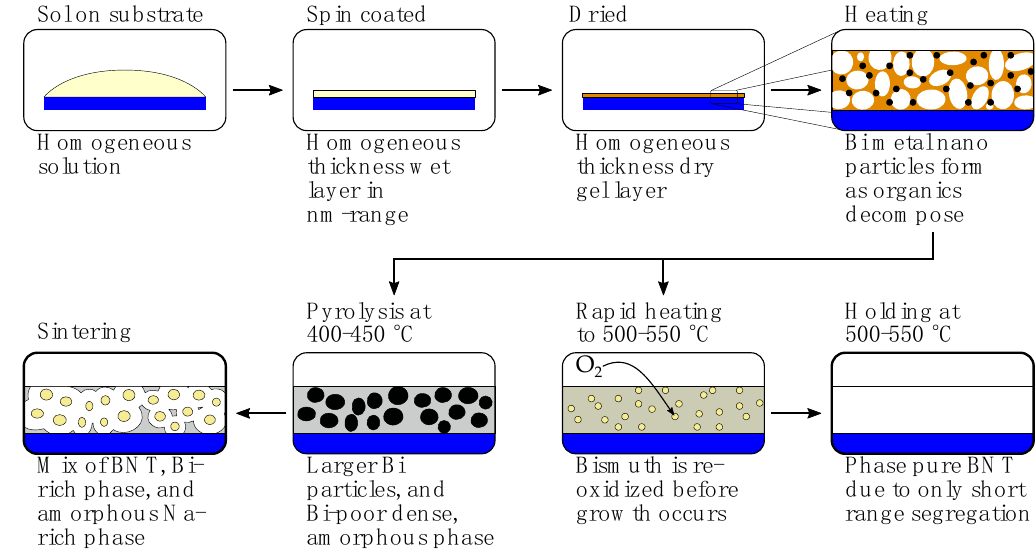
Figure 7. A schematic of the decomposition process of citrate method thin film samples. The substrate is drawn blue, pores and BNT are white, gel is brown, Bi rich secondary phase is yellow, and an amorphous Na rich secondary phase is drawn grey.